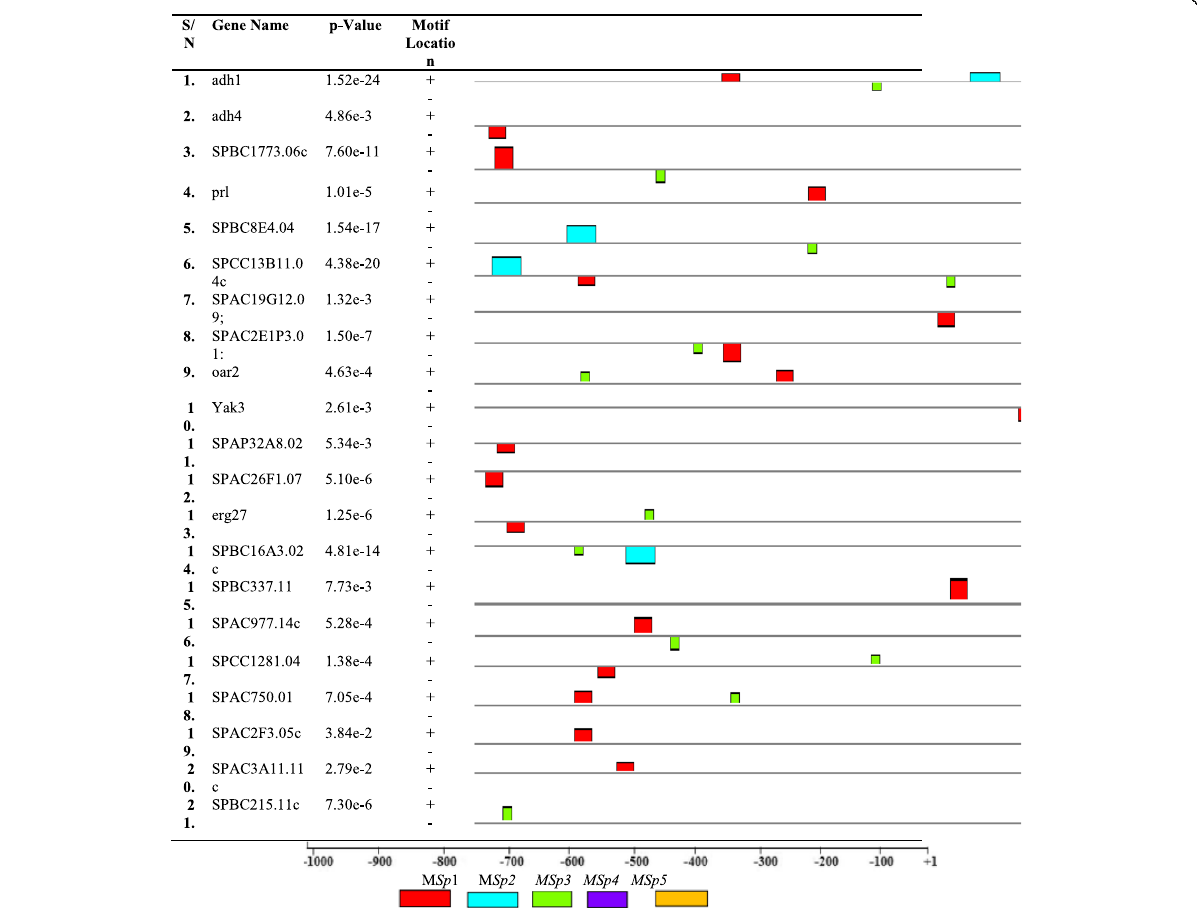
Fig. 4 The positions and strand orientation of motifs of S. pombe alcohol production gene relative to